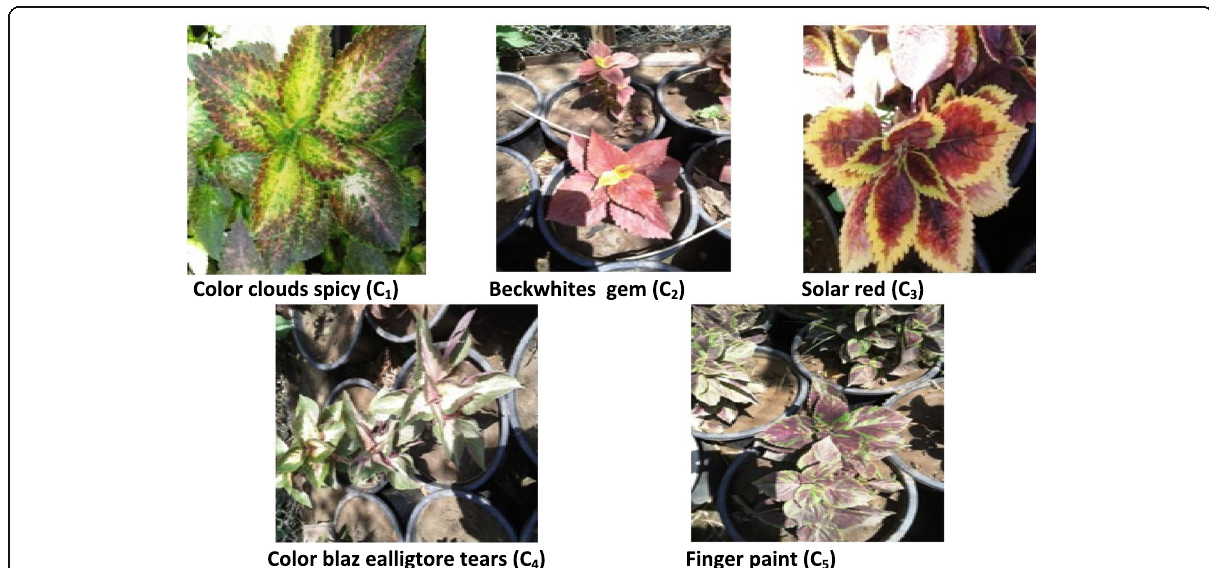
Fig. 1 Morphological description of the five Coleus